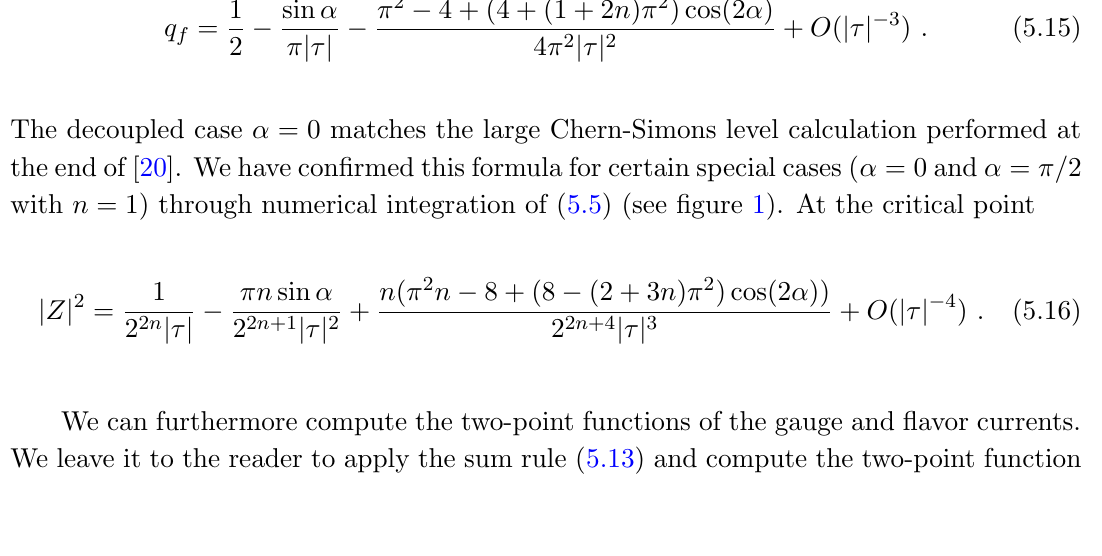
Figure 1 . The points are numerically determined values for q at di(cid:11)erent values of (cid:28) and with n = 1. The straight lines are the nonzero leading order saddle point approximations for 1 the blue curve on the left is the second order correction. In the plot on the left Re (cid:28) = 0 while in the plot on the right Im (cid:28) =